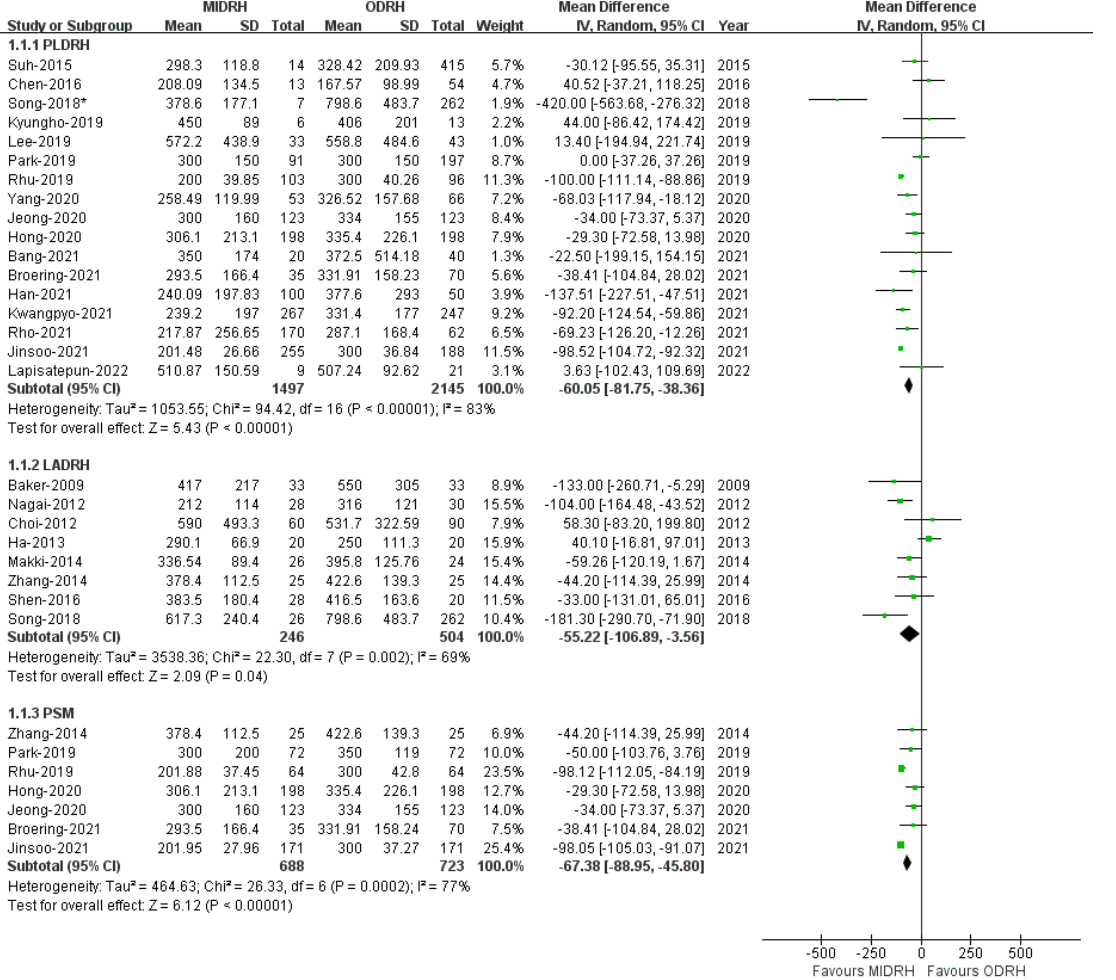
Figure 4. Forest plot comparison of MIDRH versus ODRH for intraoperative blood loss [4–7,12–31]. Figure 5. Forest plot comparison of MIDRH versus ODRH for operative time [4,5,7,12–31]. * ： *: Different data in the same Different data in the same article . * ： Different data in the same article .